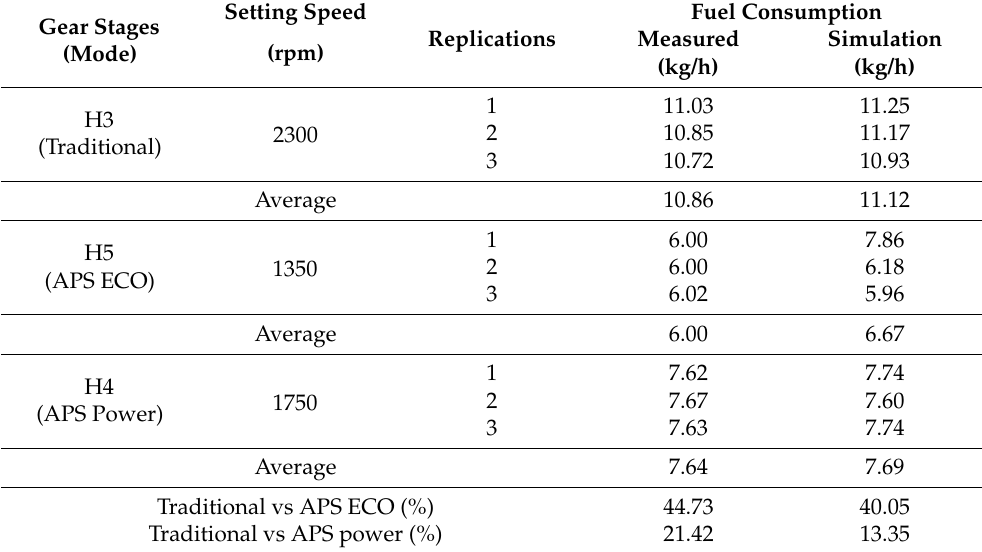
Table 5. Fuel consumption analysis during asphalt